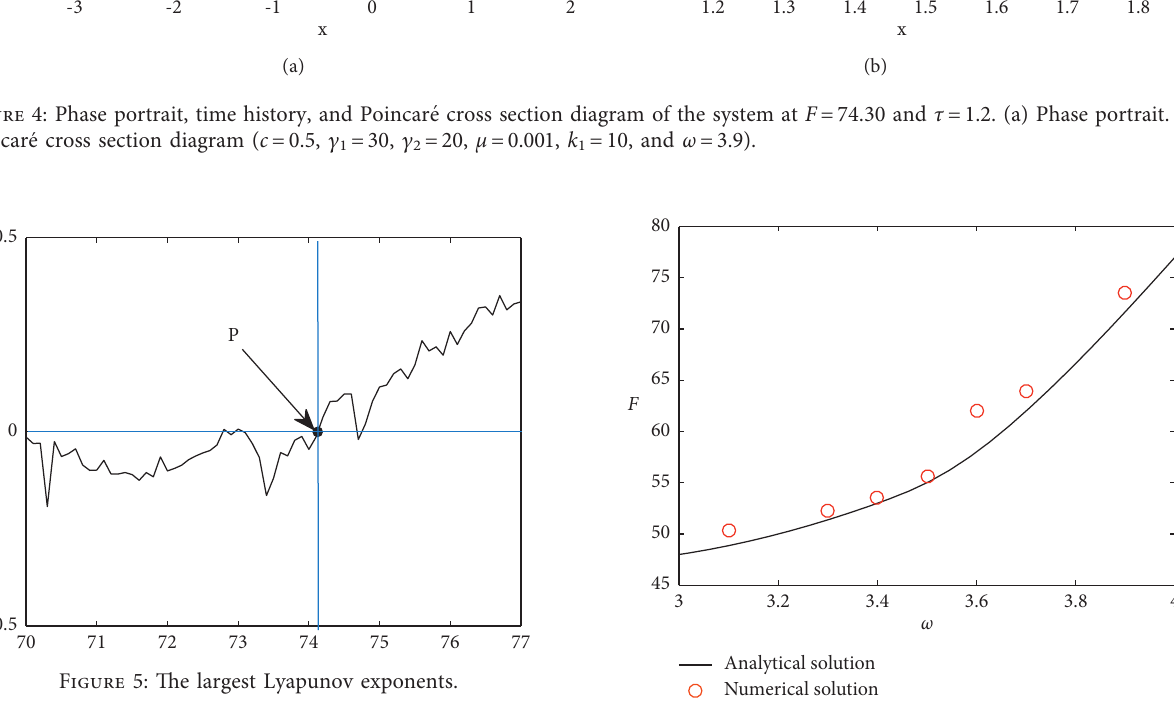
Figure 6: The comparisons between the numerical and analytical